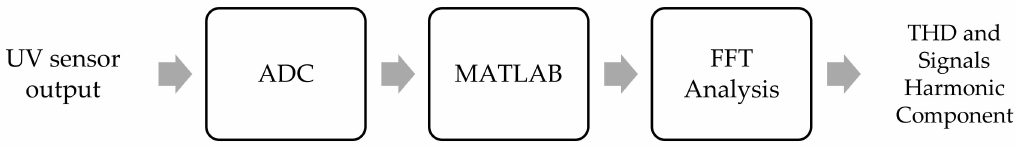
Figure 3. Schematic diagrams for Fast Fourier Transform (FFT) analysis involving ultra violet (UV) sensor, AC to DC converter (ADC), MATLAB Software, Fast Fourier Transformer (FFT) analysis and lastly the total harmonic distortion (THD) analysis.